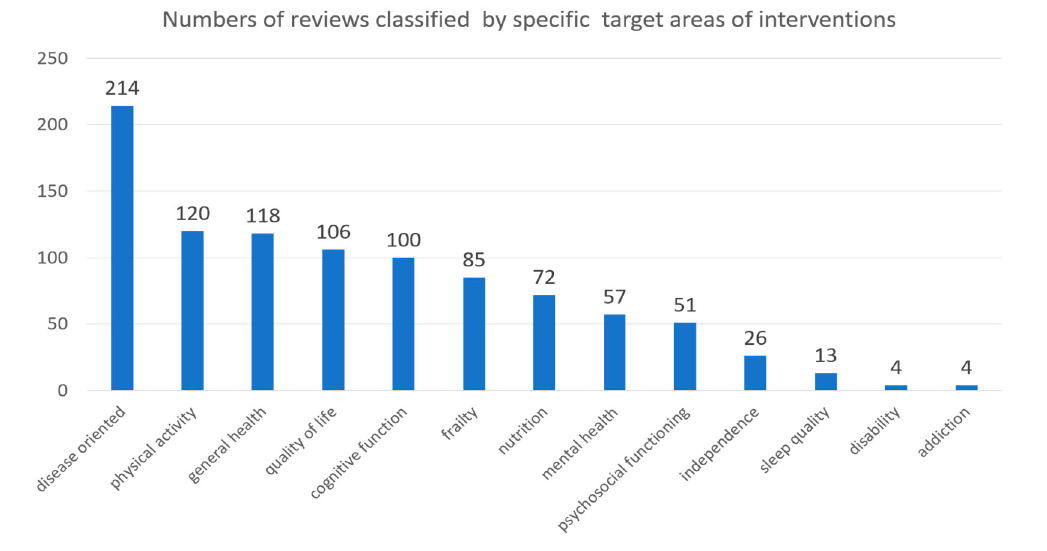
Figure 5. Number of reviews classified by specific intervention target area.